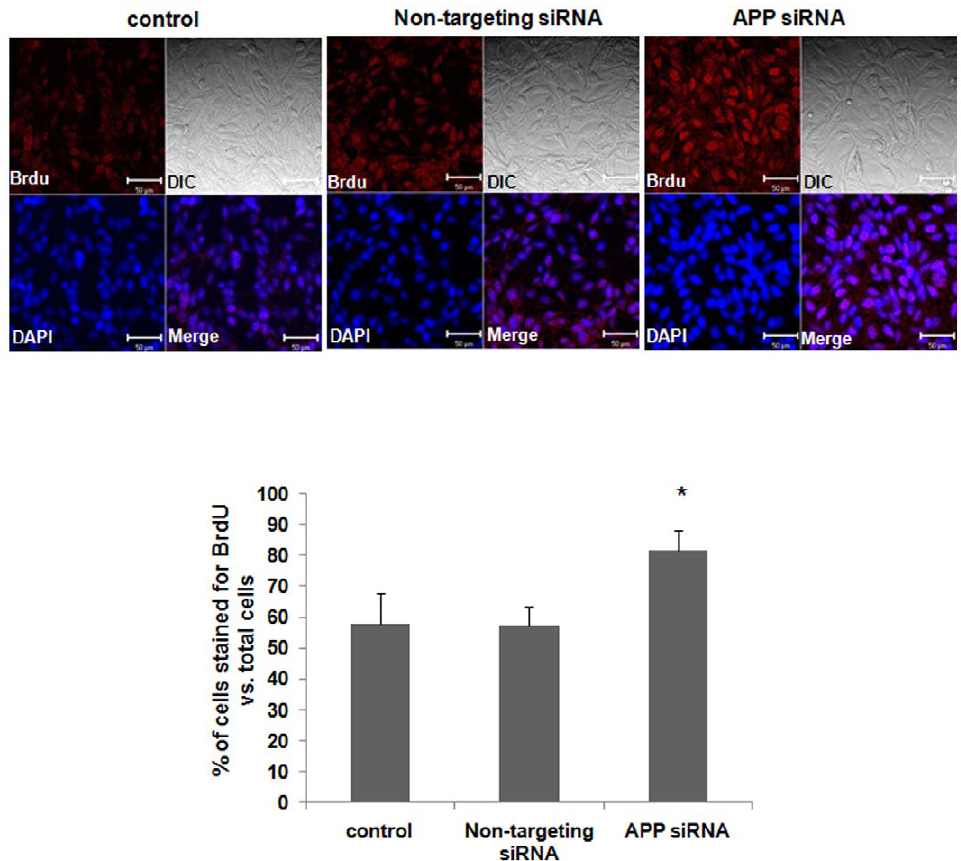
Figure 3. siRNA-mediated APP knock-down significantly increases the proliferation of fetal neural stem cells. Fetal neural stem cells were subcultured in 6-well plates, in proliferating media, and then treated the cells with 10 nM siRNAs. After 24 h, the cells were treated with BrdU (1 m M) for 24 h. We then dissociated the neurospheres, and transferred the cells to new 6-well plates with 12 mm glass coverslips pre-coated with laminin (20 m g/ml). The cells were cultured in the differentiation media without growth factors for 30 min and assessed with immunocytochemistry using an anti BrdU and Cy3-secondary antibodies. DAPI (1 m M) staining shows the location of the nucleus (blue). DIC represents differential image contrast. BrdU immunoreactive cells were calculated in five independent experiments (10 fields were evaluated per each experiment) with respect to the ratio of BrdU stained cells to total cells. Data are expressed as mean 6 SEM values. One-way ANOVA was used to determine statistical significance at p , 0.05 by post hoc analysis via Duncan’s test. Scale bars=50 m